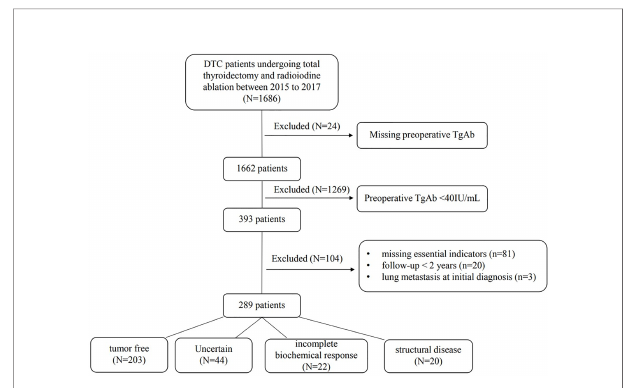
FIGURE 1 | Flowchart of patient